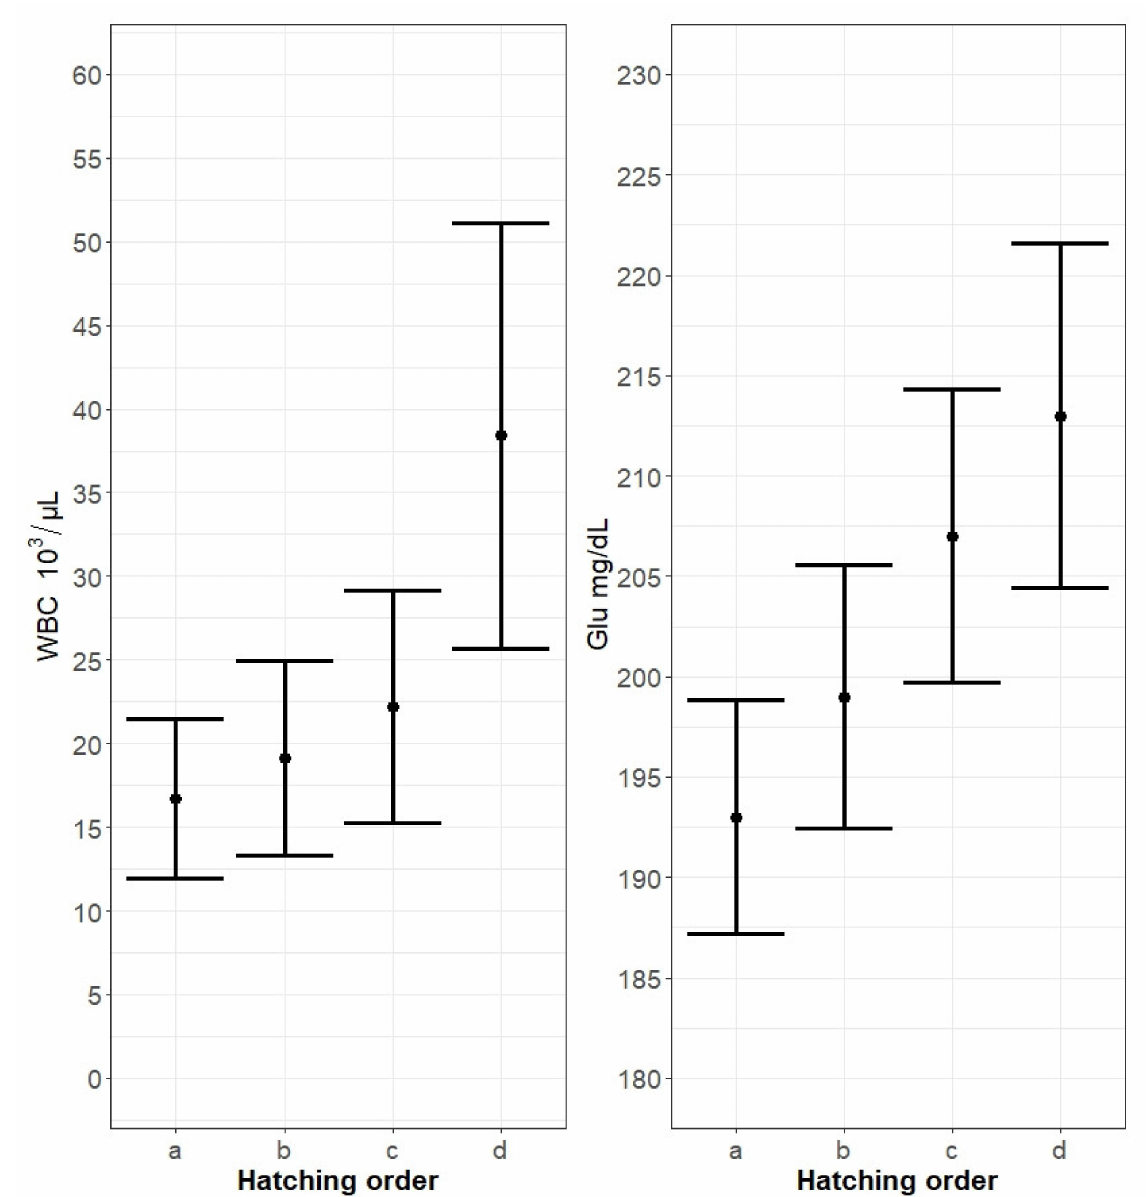
Figure 2. Variation of WBC (white blood cell) count and Glu (glucose) level in the blood of free-living marsh harrier nestlings in relation to hatching order. The hatching order of nestlings is labelled chronologically with letters ( a , b , c , and d ). Modelled means ± standard error (SE) for the best model selected are shown. Values extracted using the lsmeans